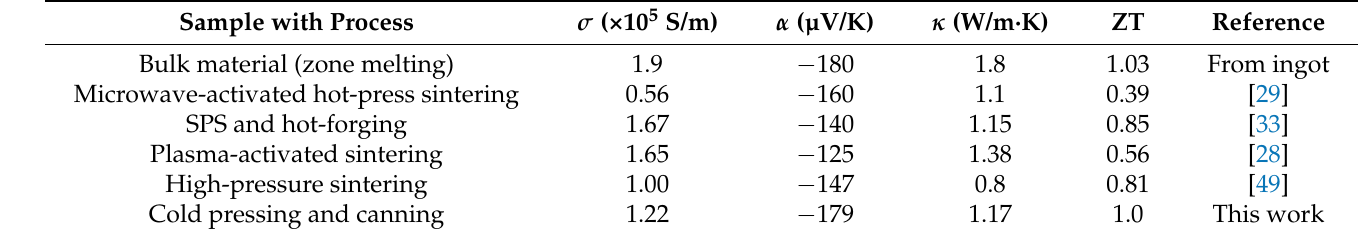
Figure 6. Schematic of ( a ) particle deformation and ( b ) texture change and grain growth from powder compaction with cold sintering at high pressure to rapid grain growth via high-temperature annealing. Table 1. Comparison of thermoelectric parameters of n-type Bi 2 Te 3 pellet with various powder processing methods. All the thermoelectric properties and ZT were measured and obtained at room